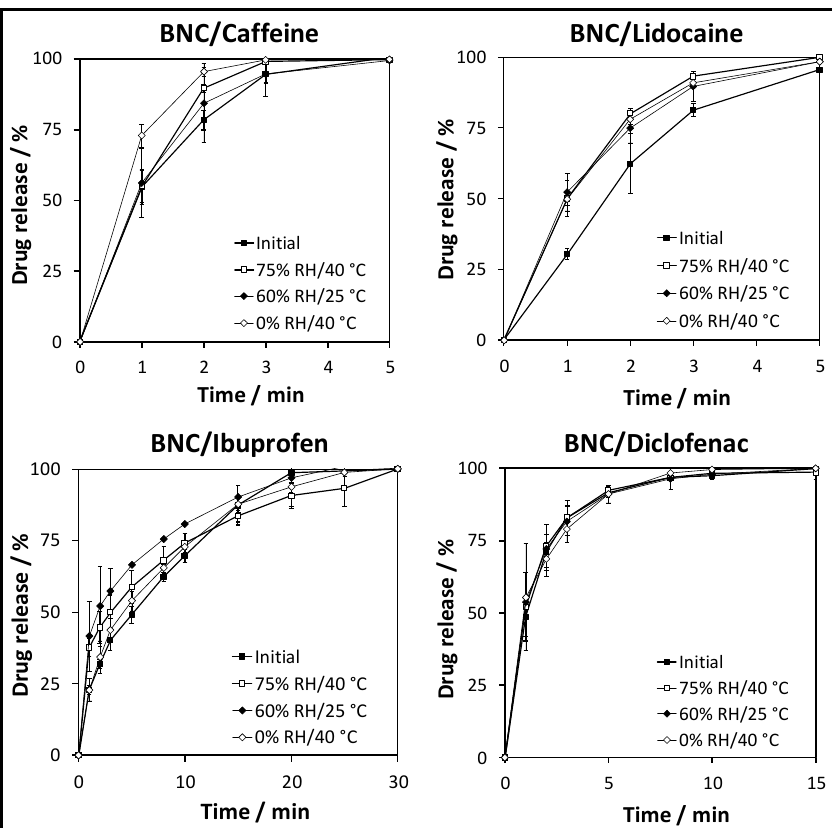
Figure 6. Drug release profiles of the API-loaded BNC membranes at time 0 (initial) and after 3 months under conditions for accelerated stability testing, namely, 75% RH / 40 ◦ C, 60% RH / 25 ◦ C and 0% RH / 40 ◦ C; the values are the mean of three replicates and error bars represent the standard deviations.